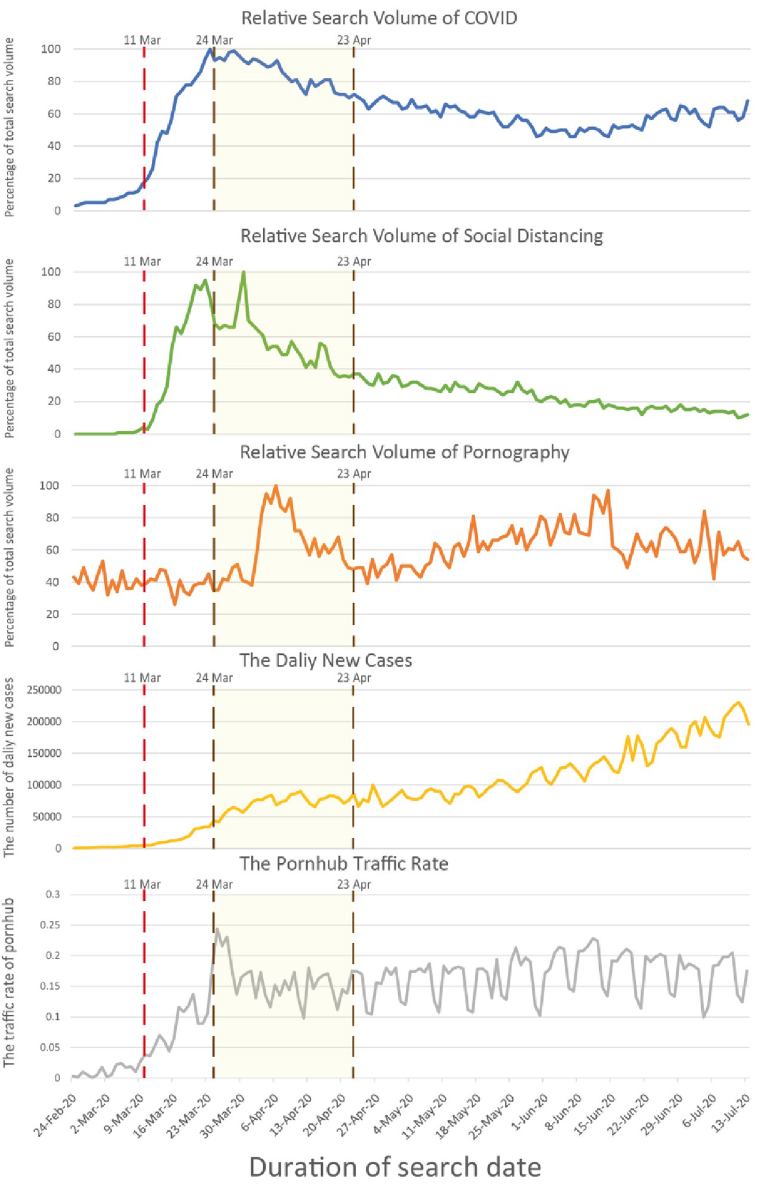
Fig 1. Relative search volume of ‘COVID’, ‘Social distancing’ and ‘Pornography’ from Google Trend(s); the Pornhub traffic rate and COVID-19 daily new cases. Note: On Mar 11, 2020, the World Health Organization (WHO) announced COVID-19 to be a global pandemic. Free promotion period of Pornhub (Premium) from Mar 24 –Apr 23, 2020.